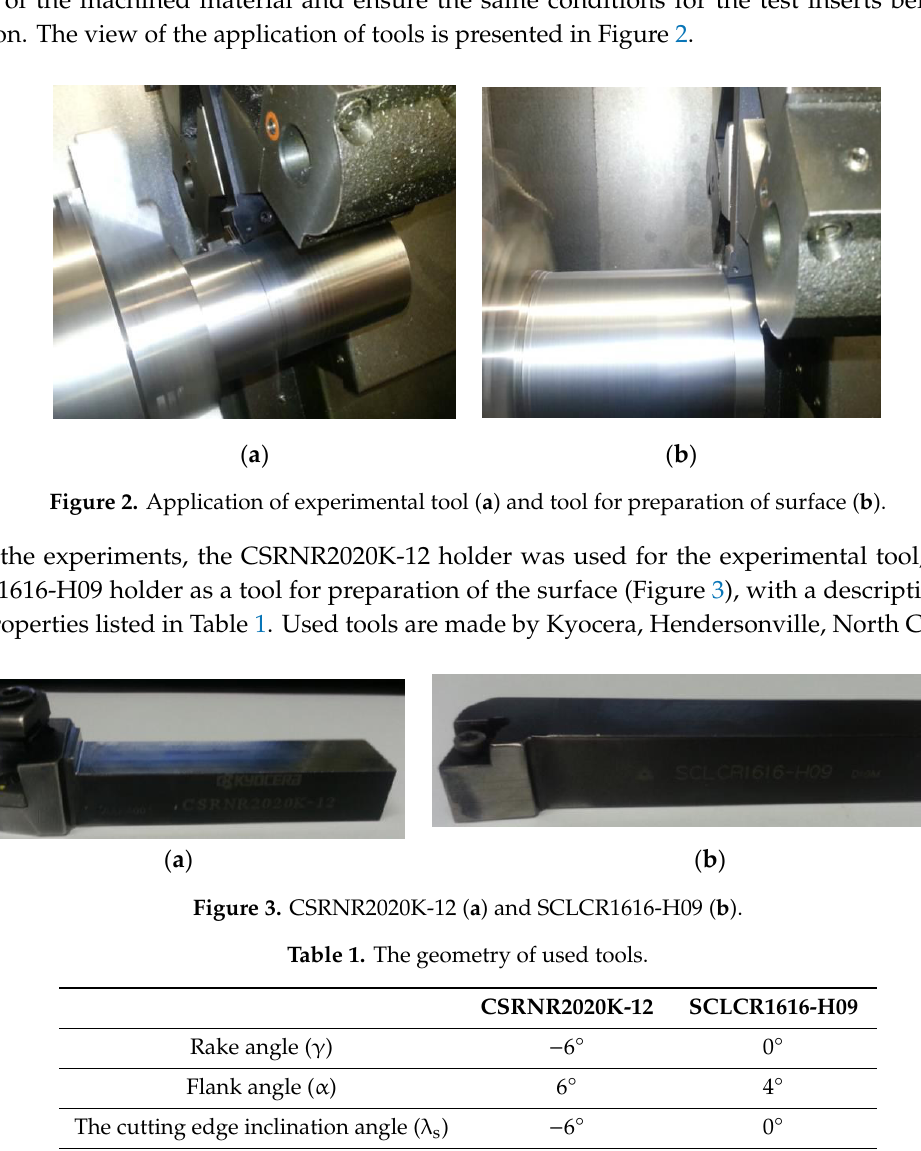
Figure 2. Application of experimental tool ( a ) and tool for preparation of surface ( b ).